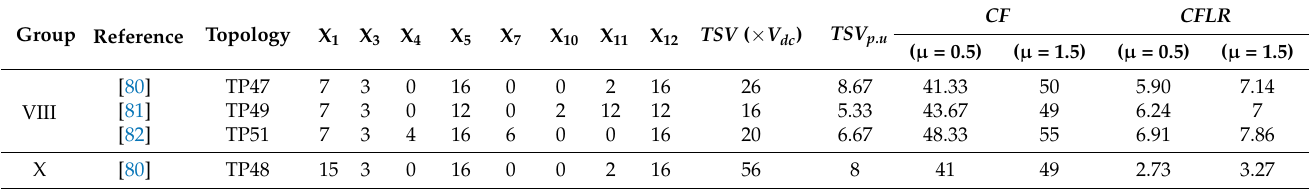
Table 4. Comparison of single-phase FT MLIs based on modules in terms of TSV , CF , and CFLR